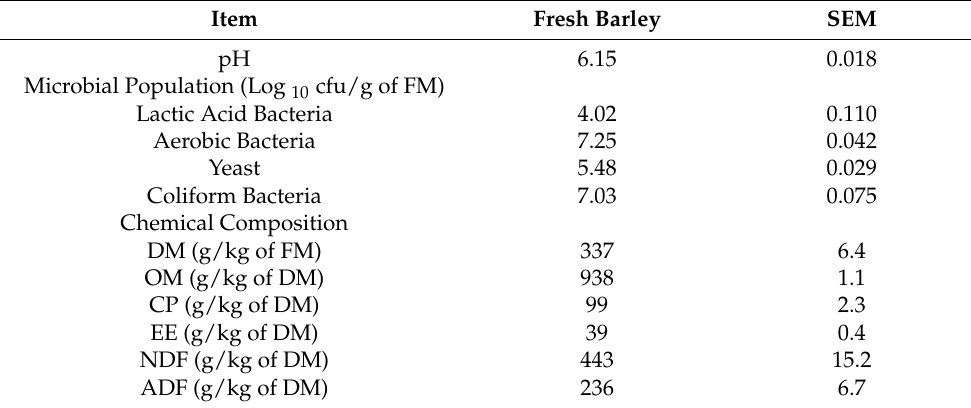
Table 1. pH, microbial population, and chemical composition of fresh barley ( n =